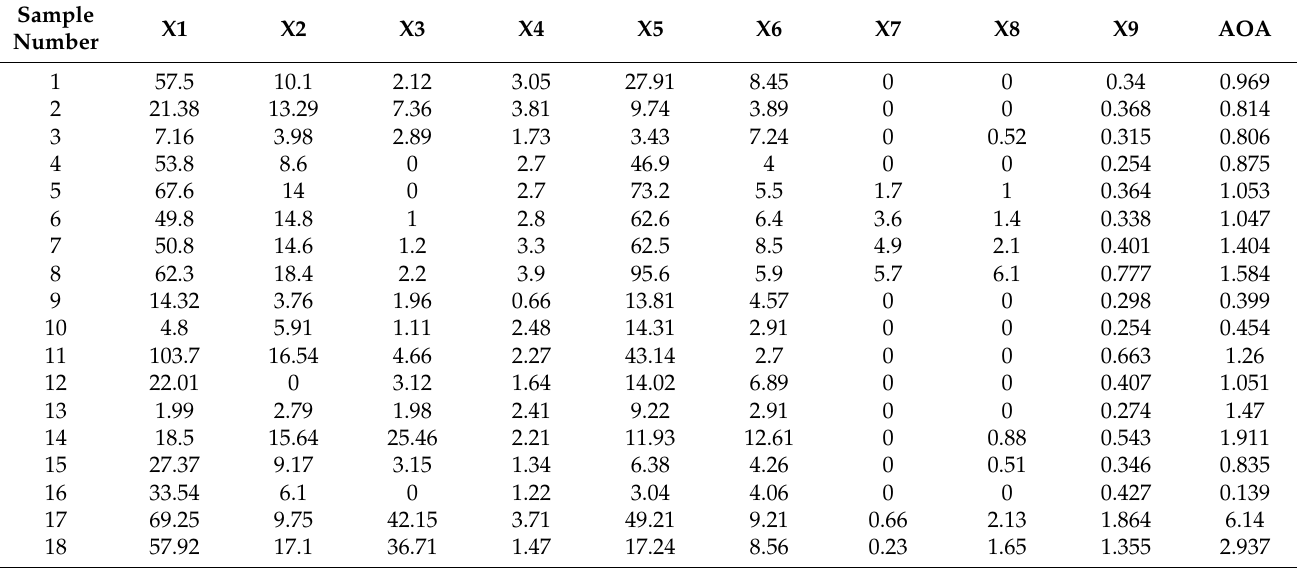
Table 4. Summary table of indicators of the mass concentration of phenolic substances and antioxidant activity of 18 samples of dry white table